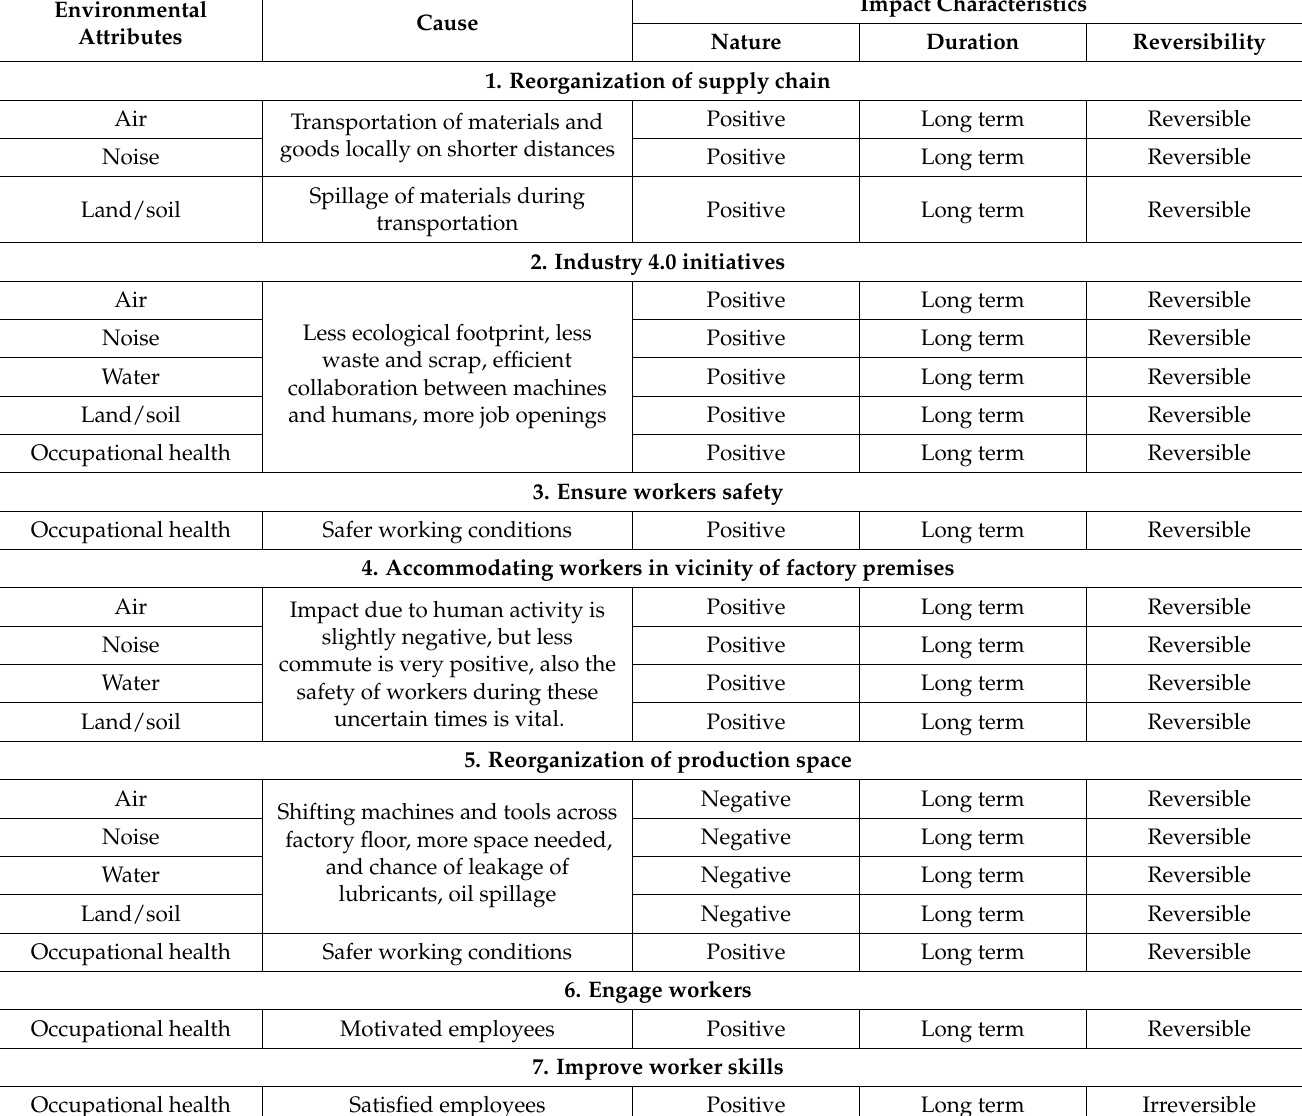
Table A5. Environmental assessment for proposed improvement